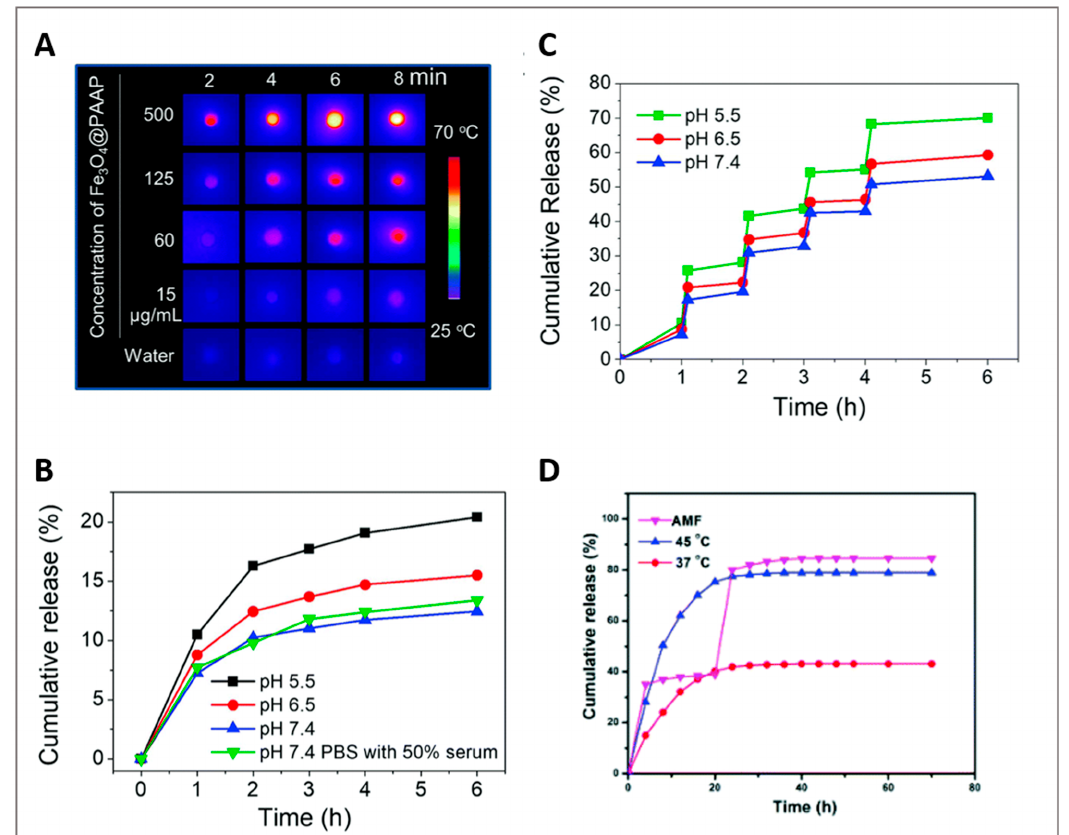
Figure 5. The multi-responsive potential of magnetic polymeric micelles. ( A – C ) DOX-Fe 3 O 4 @PAAP micelles produced from P(AAm-co-AN)-g-PEG, SPIONs and DOX, evidenced a pH and NIR irradia- tion controlled release of DOX: ( A ) Thermographic images of Fe 3 O 4 @PAAP micelles after exposure to NIR radiation (808 nm laser at 2 W cm − 2 ); ( B ) Cumulative release curves of DOX in PBS (pH 5.5, 6.5 and 7.4) with or without serum at pH 7.4; ( C ) Cumulative release curves of DOX in PBS (pH 5.5, 6.5, and 7.4) upon irradiation with a NIR laser for 3 min. ( D ) Cumulative release curves of DOX from PPI- b -TEGME, SPIONs and DOX micelles at 37 ◦ C, 45 ◦ C, and after a 5 min exposure to an AMF. Adapted with permission from Refs. [8,32]. Copyright 2022, The Royal Society of